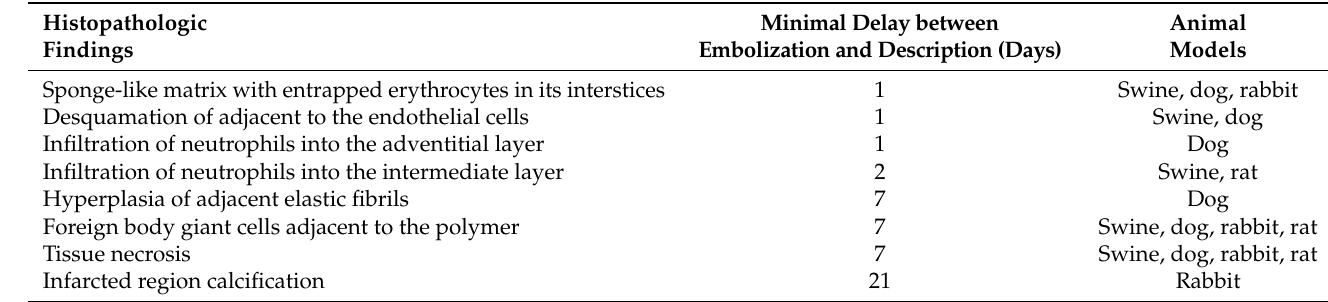
Table 4. Main histopathologic findings from studies of animal models [3–6,8,13–15,17,27–29,32–36,39–41,45,46,57,59]. Histopathologic Findings